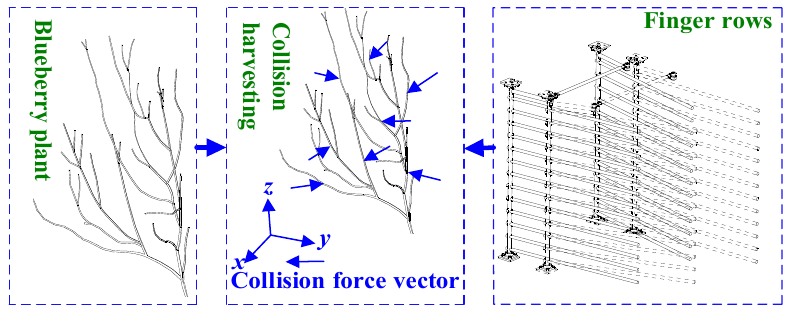
Figure 3. Diagram of multipoint collision of blueberry